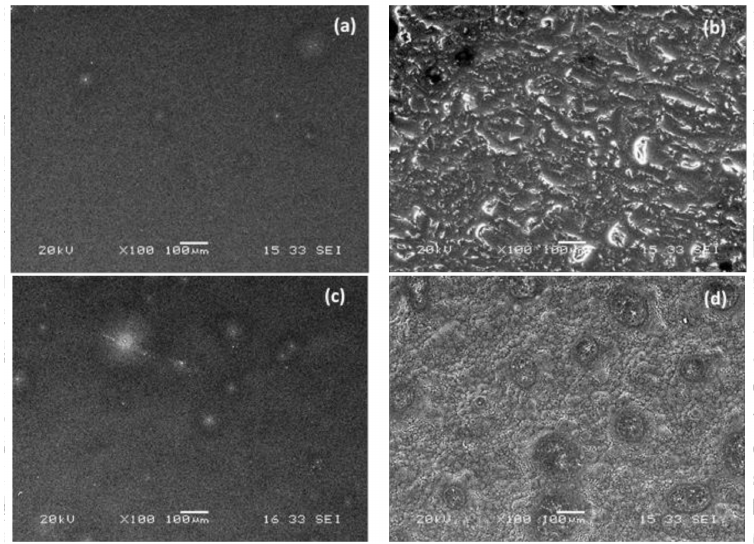
Figure 3. Scanning electron microscopy. Homogeneity of PDMS 13 -methoxy-ended cross-linked film with hydrophilic compounds incorporated ( a ) 6-TMS ( b ) 45-OH ( c ) PDMS-TMS , and ( d )